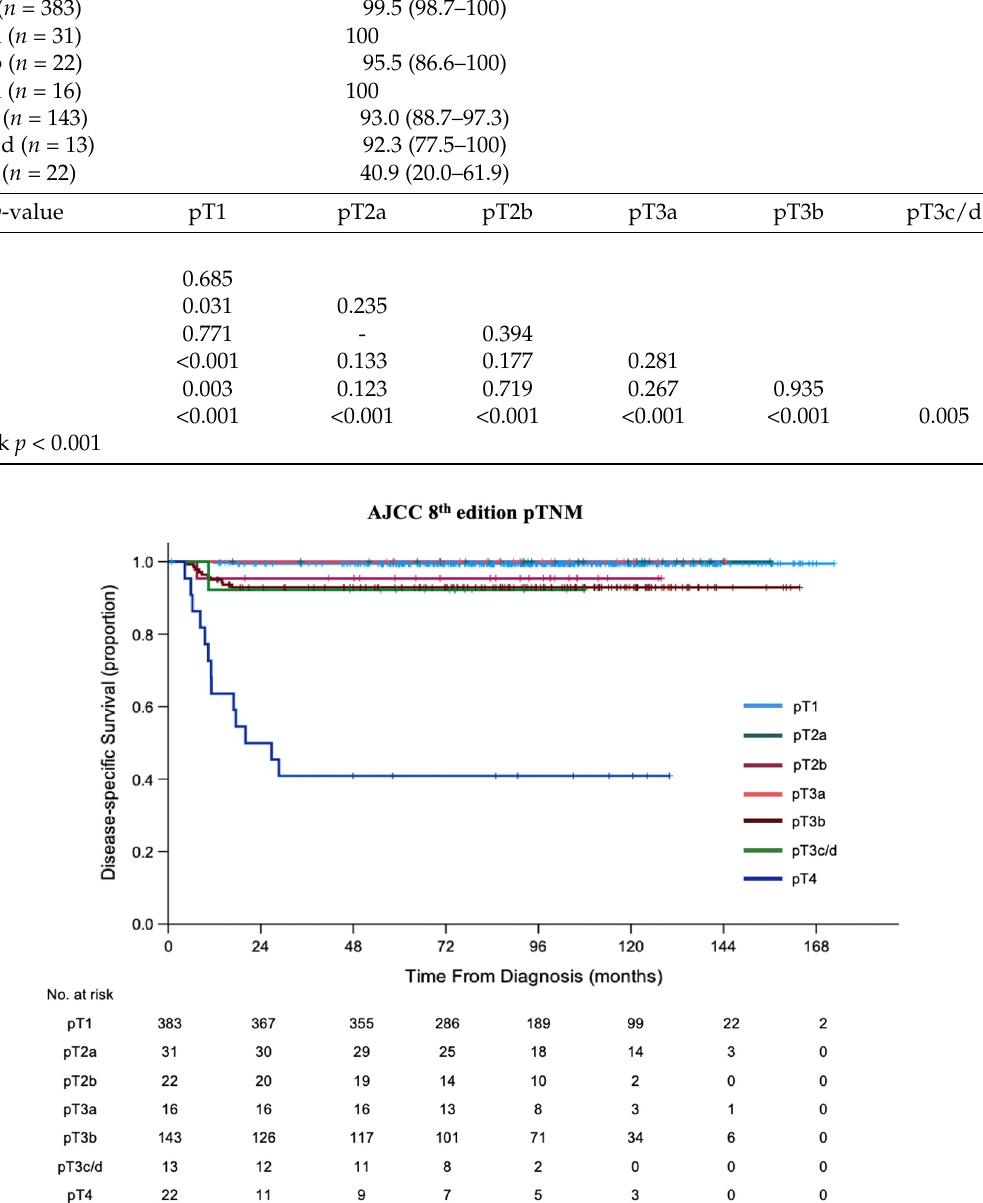
Figure 2. Kaplan–Meier curves of disease-specific survival (DSS) of patients treated with primary enucleation classified by AJCC 8th edition pTNM.